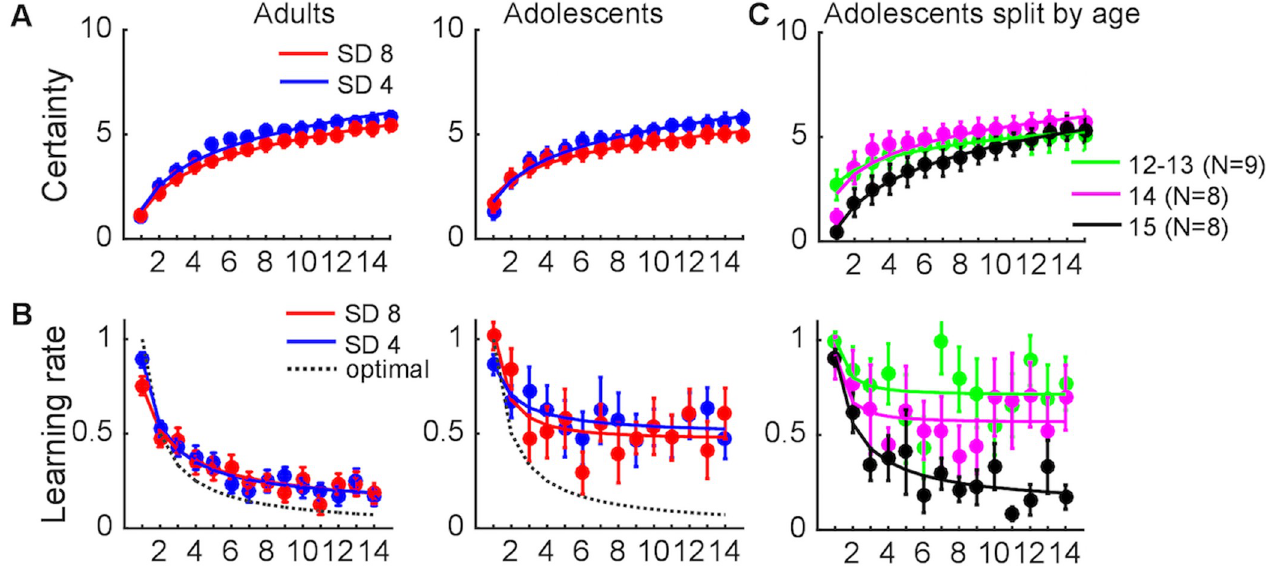
Fig 2. Changes in certainty and learning rate over time. A . Certainty rating as a function of trial, noise level and age group. B . Learning rate (directly computed from the estimation data) as a function of trial, noise level and age group. Note that we could not compute learning rate for the last trial of each block (trial 15) as participants did not update their estimate after the fifteenth observation. The dotted gray lines show the optimal learning rate on each trial of this task. C . Certainty rating and learning rate in the adolescents, as a function of trial and age. Error bars indicate standard errors. The lines are power-function fits to the mean time-courses of each age